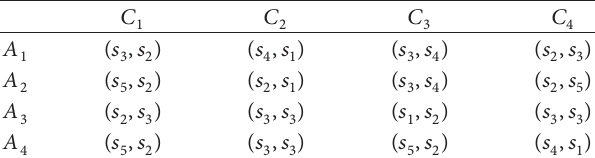
Table 5: The aggregated decision matrix 𝑅 by LIFOWG